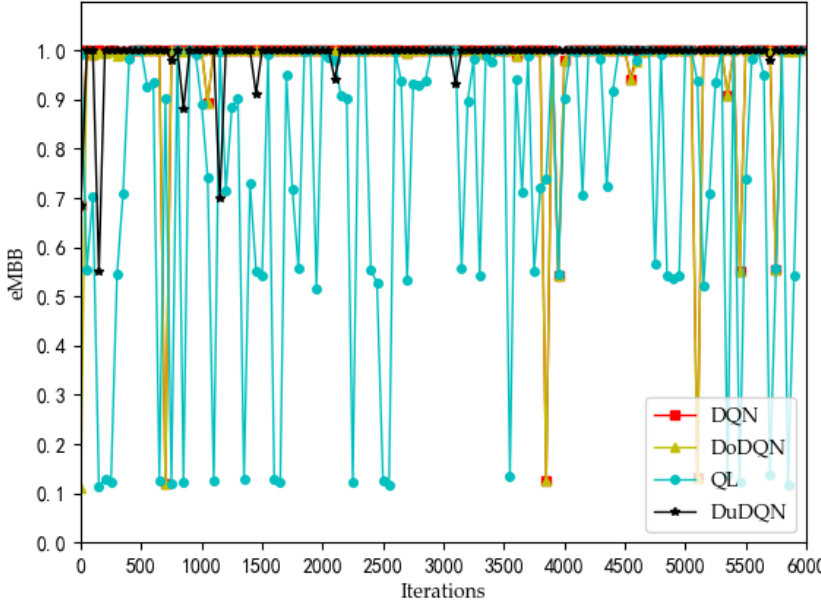
Figure 9. Comparison of QoE of eMBB using different methods (taking MVNO-1 as examples).